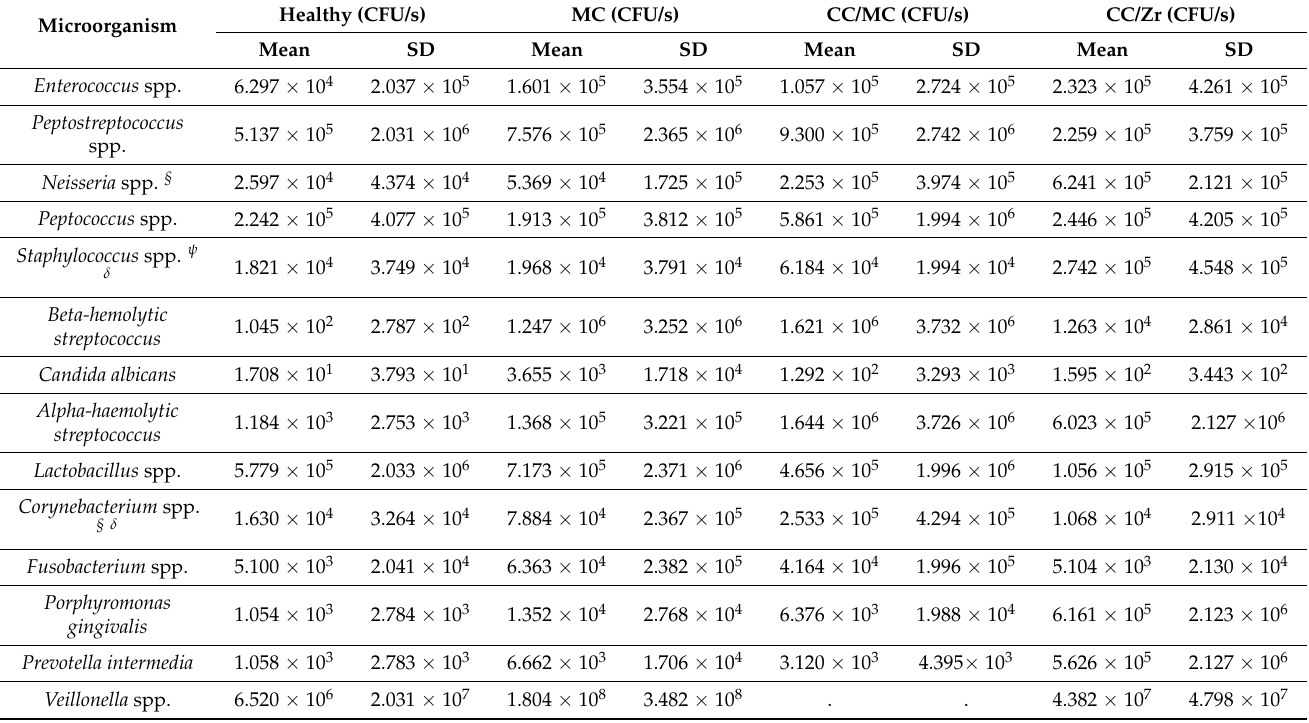
the CC-MC group. Veillonela spp. was observed in a greater number in the healthy and CC-Zr groups, and Beta-hemolytic streptococcus was observed in a greater number in the MC and CC-MC groups. Table 2. Microbiologic composition and counts of the GCF in all groups before